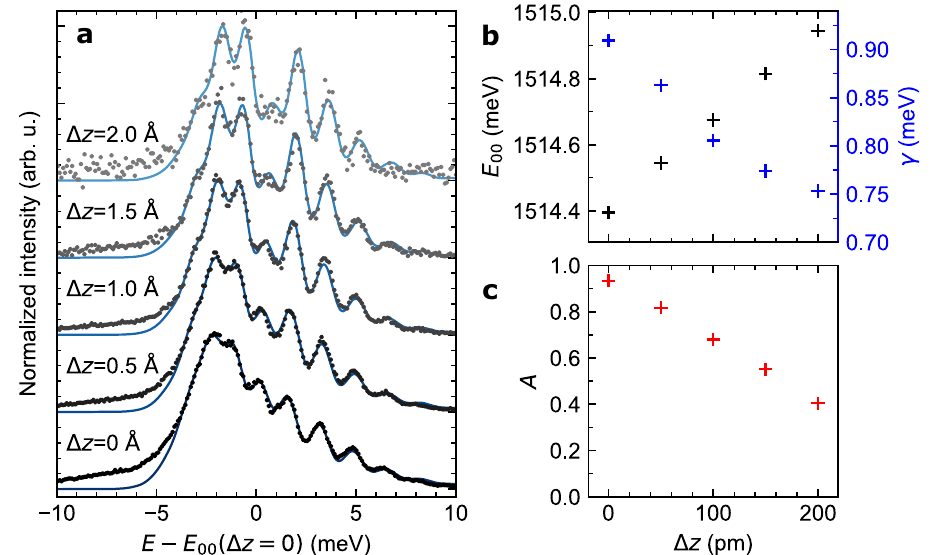
Fig.4|Evolutionoflibronic fi ngerprintswiththegapsize.a Experimental(black dots) and simulated (solid blue lines) STM-EL fi ne spectra of Q + peak of MgPc + as a function of increasing tip-sample separation by Δ z . V = − 3V, I ranges from 113pA (bottom spectrum) to 19pA (top spectrum). Acquisition time was 120s for Δ z =0, 0.5, 1Åand 360sfor Δ z=1.5and 2Å. b , c The energy E 00 , linewidth γ and reducing